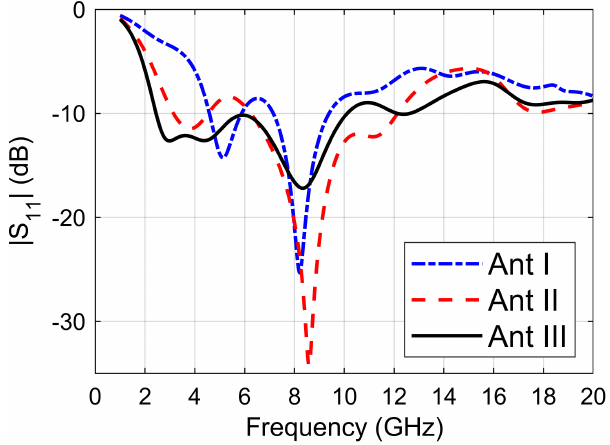
FIGURE 5. Simulated |S 11 | of radiating patch design procedure for antennas shown in Fig. 4.